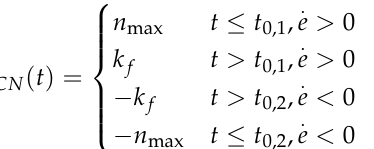
26 of 29 reduces the amplitude error by 29.8% and corrects the phase lag of 10°. Compared with the normal PID controller, this method reduces the amplitude error by 46.3% and it cor- rects the phase lag of 15°. It can also be seen from Figure 27e that the change of temperature and load has little effect on the delay compensation control method. Periodically changing load will cause a slight jitter of position output, but it will not affect the delay. According to Equations (32) and (33), the temperature change will change the effective bulk modulus b , thus chang- ing the delay